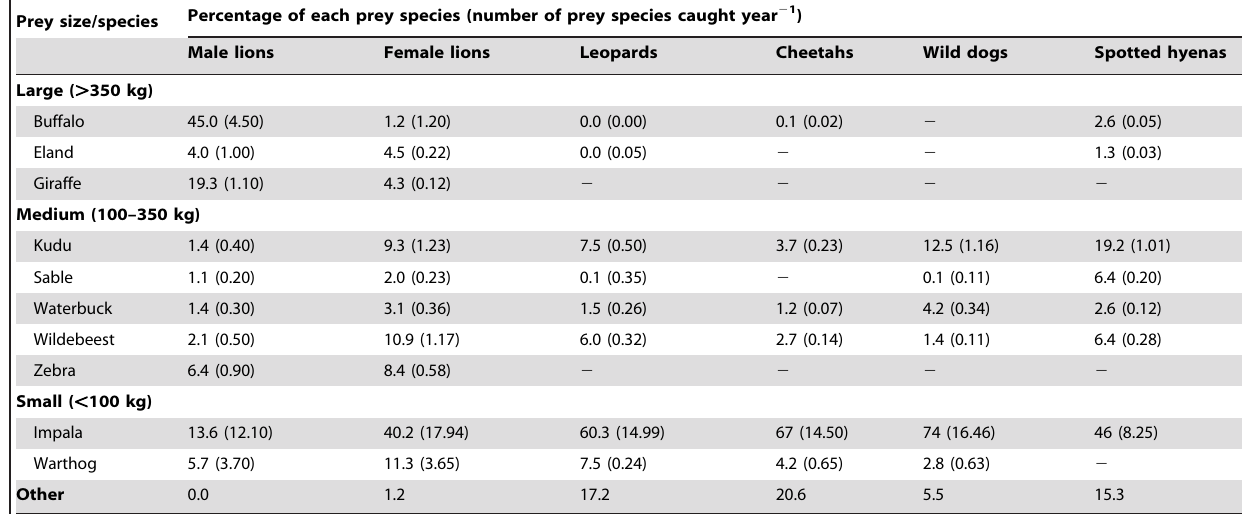
Table 3. Percentage of herbivores in the diet of the large predators used in the development of the model, with the estimated number of each key ungulate species caught per individual predator per